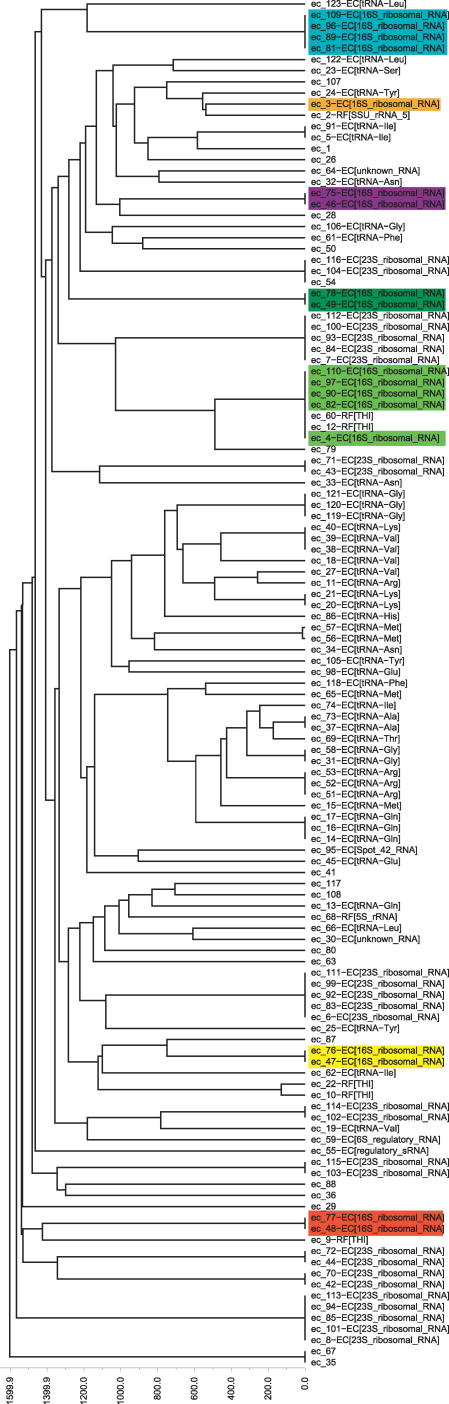
Complete WPGMA Clustering Tree for ncRNA Candidates in Gammaproteobacteria E. coli
Candidates are annotated with known E. coli ncRNAs (EC[...]), or if such do not exist, then with ncRNAs from the RFAM database (RF[...]). The colored boxes correspond to different substructures of 16S as found by the RNAz screen. See Figure 3 for the location of these substructures. The situation is the same for 23S (see File Collection S1).